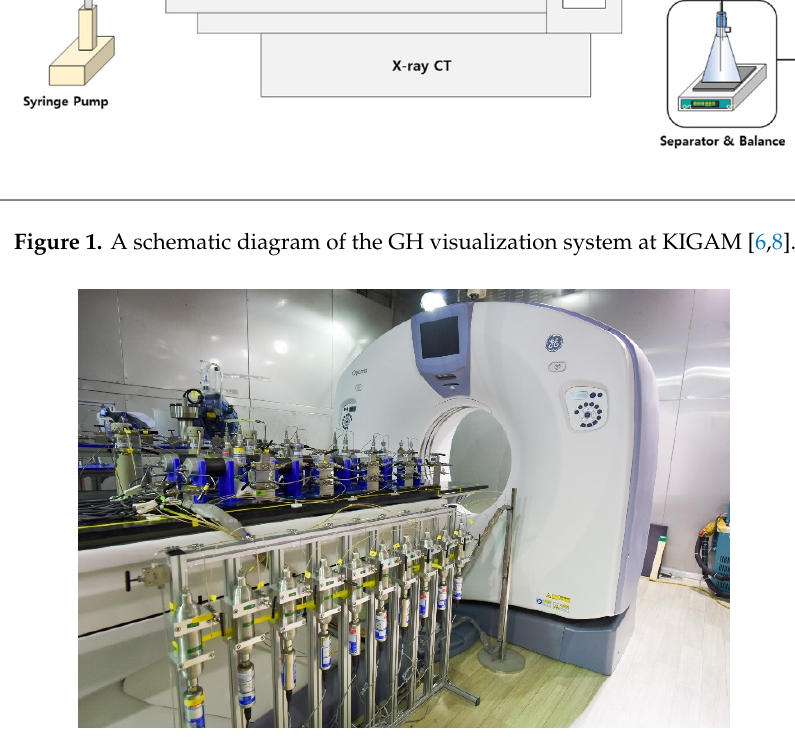
Figure 2. The installed X-ray CT equipment for the GH visualization system at KIGAM [8,10].